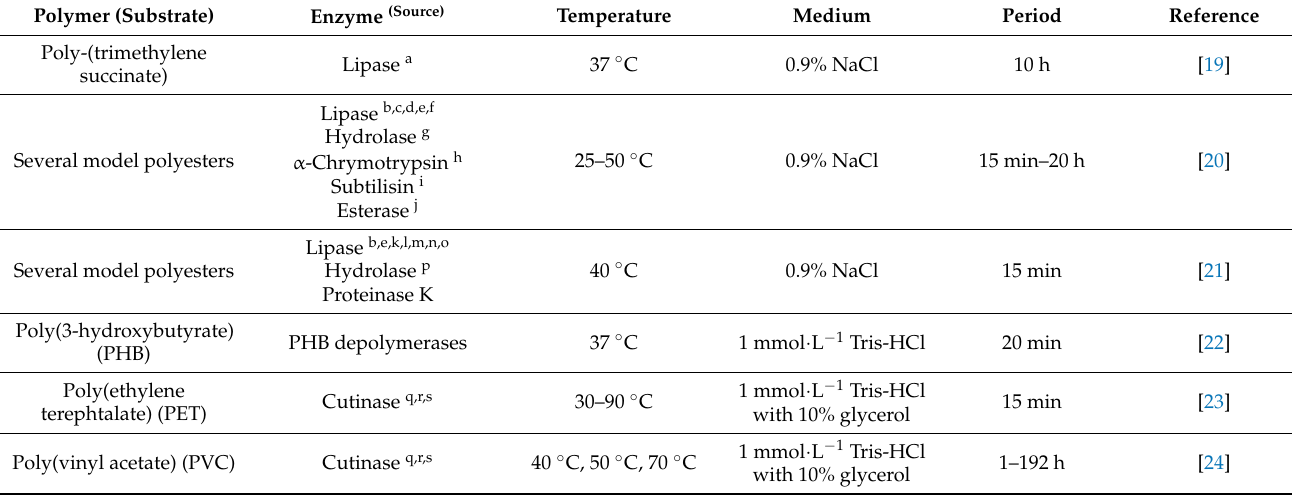
Table 1. Procedural parameters of reported polymer degradation experiments by pH Stat